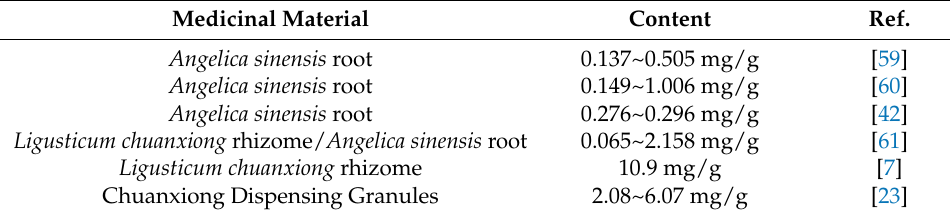
Table 2. Contents of SI in medicinal materials.